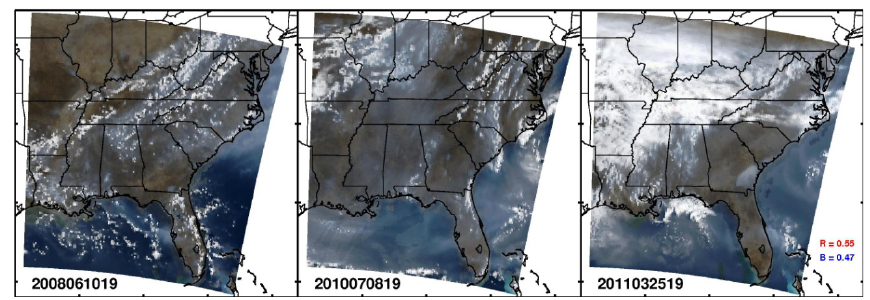
Figure 8 Fig. 8. Synthetic RGB imagery at 19:00UTC, 10 June 2008 (left), 8 July 2010 (middle), and 25 March 2011 (right). The green band reflectance is synthesized from the simulated blue and red band reflectance using the relations, G syn = 0 . 4 · B + 0.6 · R for land, ocean, aerosol, and cloud, and G syn = 0 . 6 · B + 0.6 · R for